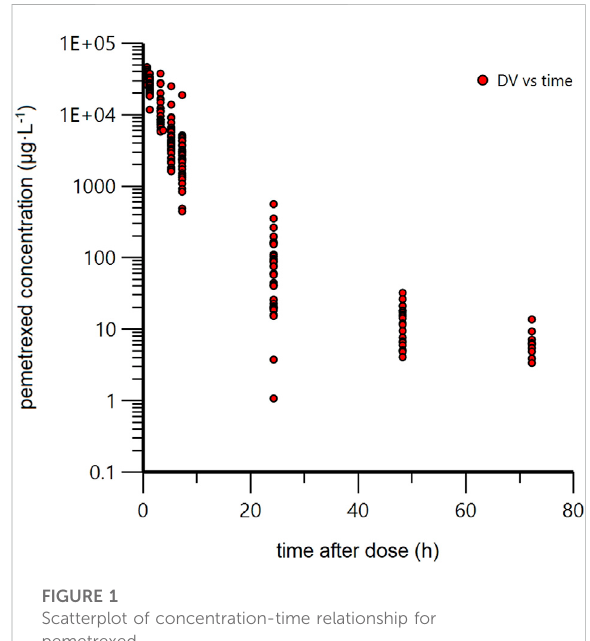
FIGURE 1 Scatterplot of concentration-time relationship for